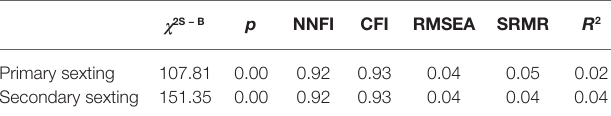
TABLE 6 | Fit statistics for the models NfP to sexting to test gender invariance. Χ 2 (Δ Χ 2 )